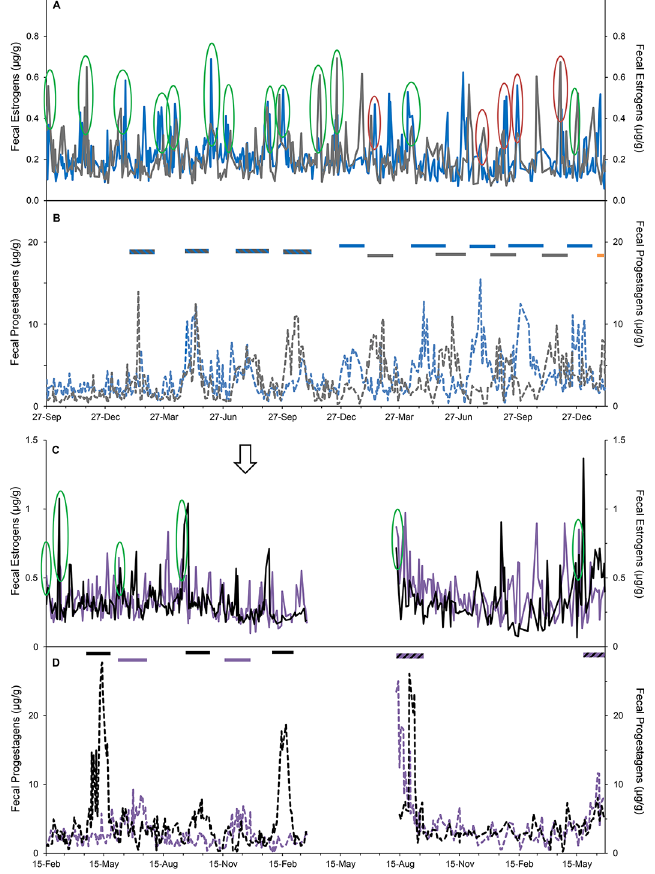
(black profile) and SB172 (purple profile). Fecal estrogen metabolites ( μ g/g) are displayed in panels A and C with solid lines and fecal progestagens metabolites ( μ g/g) in panels B and D with dotted lines. Green circles indicate synchronized estrous cycles for the pair of females at each zoo and for SB246 and SB247, red circles show incidences of shared peak FEM while one female was in a luteal phase. Striped horizontal lines denote synchronized luteal phases caused by spontaneous ovulation events within a zoo, solid horizontal bars indicate luteal phases caused by spontaneous ovulations for each individual (not synchronized) and the orange horizontal bar represents the start of a pregnancy (SB246; the male was introduced to this female six weeks prior to the successful pregnancy). In panel C, the arrow signifies the arrival date of the male lion (SB215) to the zoo, but physical introductions between the females and the male were not conducted for more than 1.5 yr after his